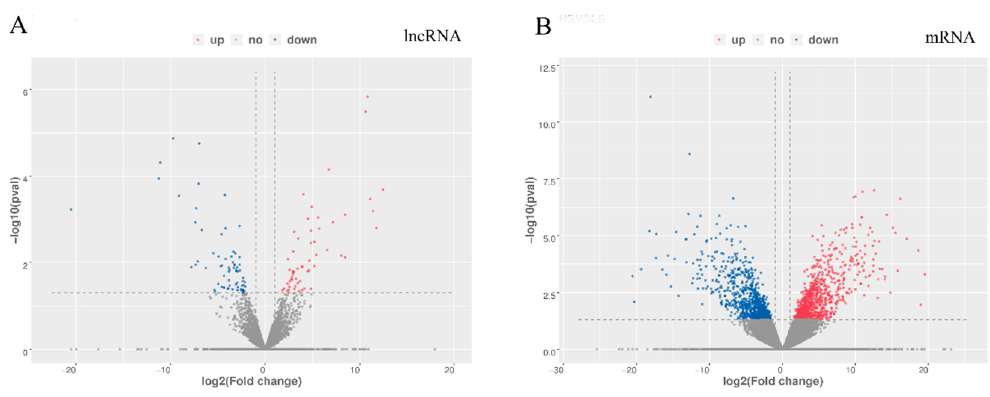
Figure 3. The differential expression of lncRNAs and mRNAs between high and low sperm motility groups. ( A ) Differential expression of lncRNAs. The blue points denote significantly up-regulated lncRNAs, while the red points denote significantly down-regulated lncRNAs in high sperm motility testes. ( B ) Differential expression of mRNAs. The blue points denote significantly up-regulated mRNAs, while the red points denote significantly down-regulated mRNAs in high sperm motility